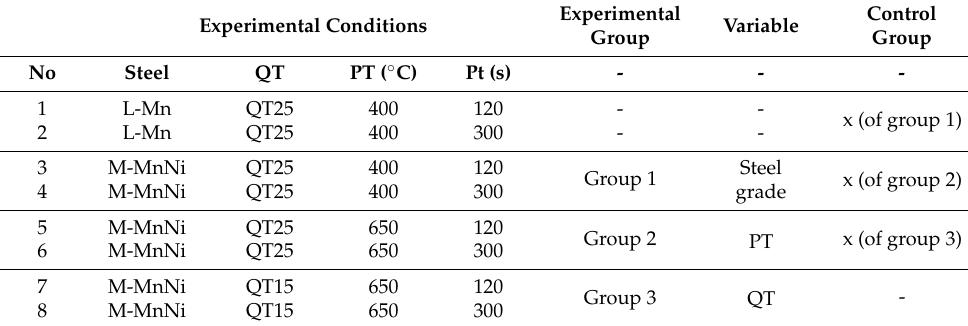
Table 2. Experimental conditions, experimental groups, variables and control group. Experimental